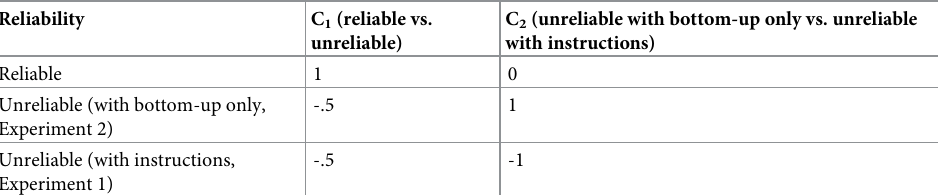
Table 3. Helmert coding of reliability conditions.